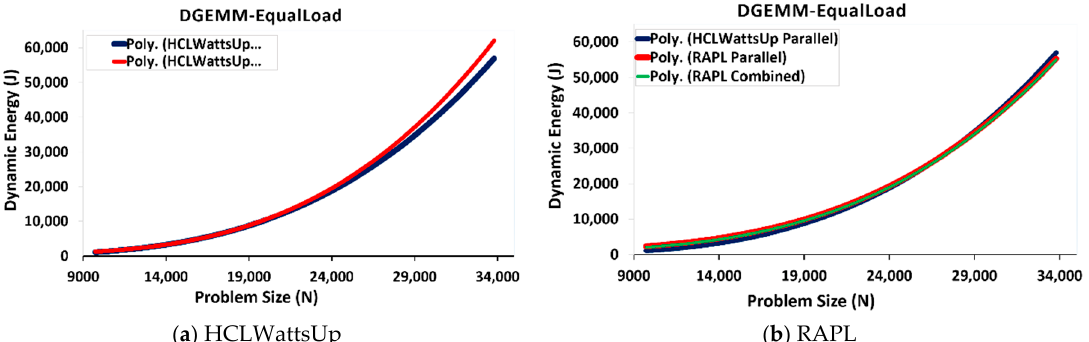
Figure 3. Regression models of energy profiles in set of energy profiles (EPS) DGEMM_EqualLoad constructed with ( a ) HCLWattsUp, and ( b ) RAPL. Here, DGEMM refers to Double-precision General Matrix Multiplication application.